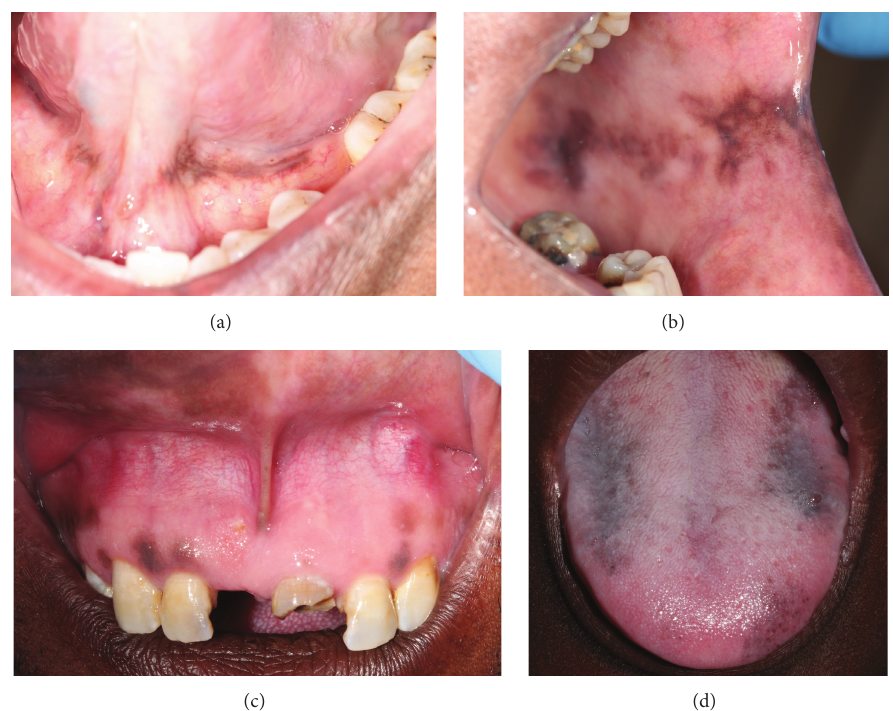
Figure 1: Clinical illustration of HIV-OMH. (a) Melanin hyperpigmentation of the floor of the mouth of a female 42-year-old nonsmoker who was HIV-seropositive with a CD4+ T cell count of 25 cells/mm 3 . She had been diagnosed with HIV disease 3 years previously. Highly active antiretroviral therapy (HAART) was started immediately after the diagnosis, and the hyperpigmentation appeared some time later. (b) Irregular, nonhomogeneous pigmented patch on the buccal mucosa of a 69-year-old HIV-seropositive male with a CD4+ T cell count of 88 cells/mm 3 . He had been diagnosed with HIV infection seven years previously. HAART was started after 2 years and the hyperpigmentation appeared 4 years later. The patient is a nonsmoker. (c) Multiple, pigmented maculae on the maxillary gingiva and labial mucosa of a 40- year-old HIV-seropositive male with a CD4+ T cell count of 141 cells/mm 3 . He had been diagnosed with HIV disease 10 years previously and HAART was started immediately. The hyperpigmentation appeared two years later. (d) Multiple pigmented maculae of the dorsum of the tongue in a 32-year-old HIV-seropositive male on HAART with a CD4+ T cell count of 422 cells/mm 3 . He had been found to be HIV- seropositive eight years previously and HAART was started a year later. The patient recalls that the hyperpigmentation developed after the start of HAART medication but he is unsure exactly when it appeared. None of the patients whose oral pigmentation is illustrated had any other oral soft tissue abnormalities or any known systemic